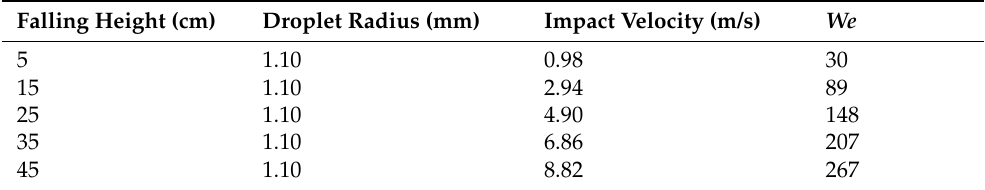
Table 1. The impact velocities and We numbers corresponding to water droplets of different falling heights.